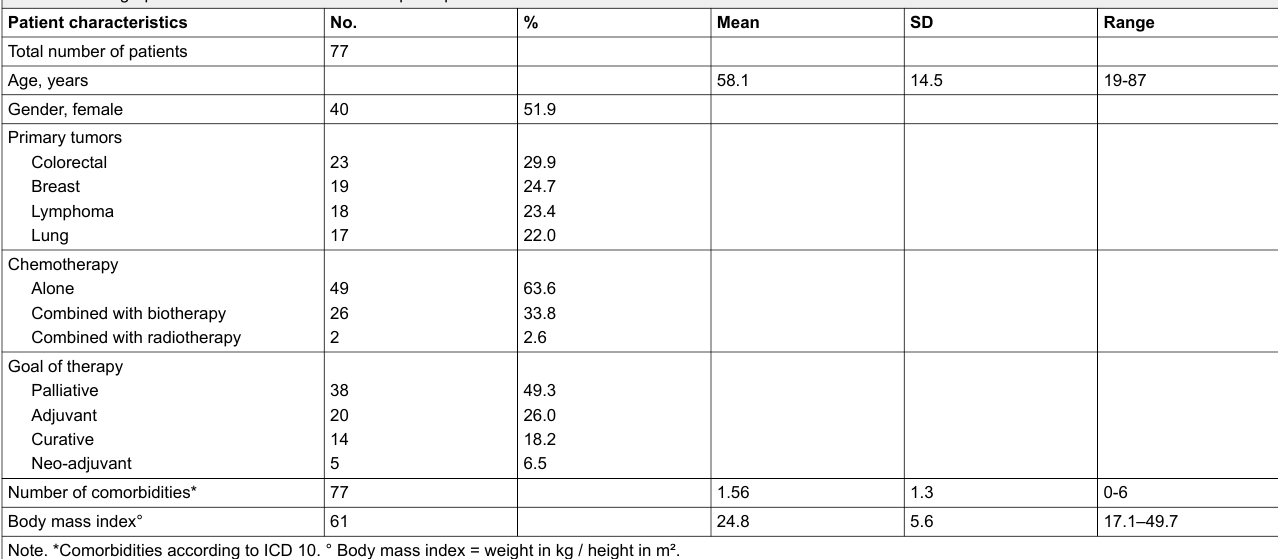
T1 (N = 77) Mean ± SD (range)